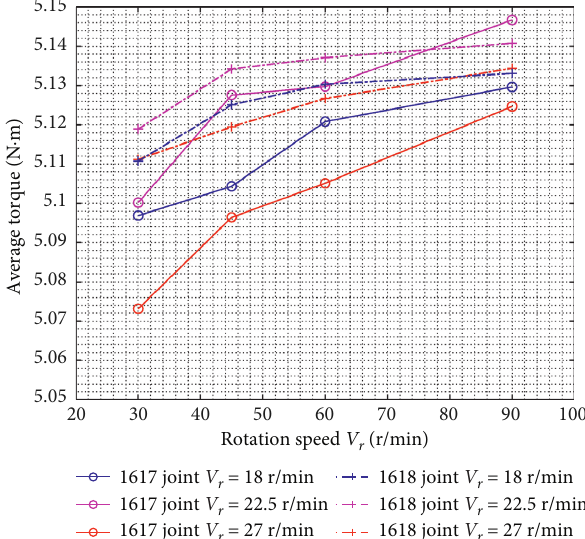
Figure 11: Variation of the average of torque changing with ro- tation